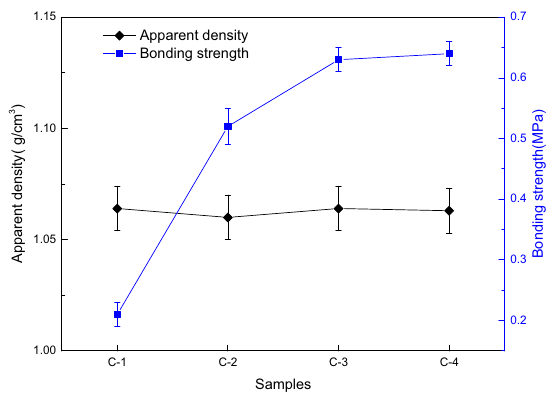
Figure 9: Physical and mechanical properties of composites.